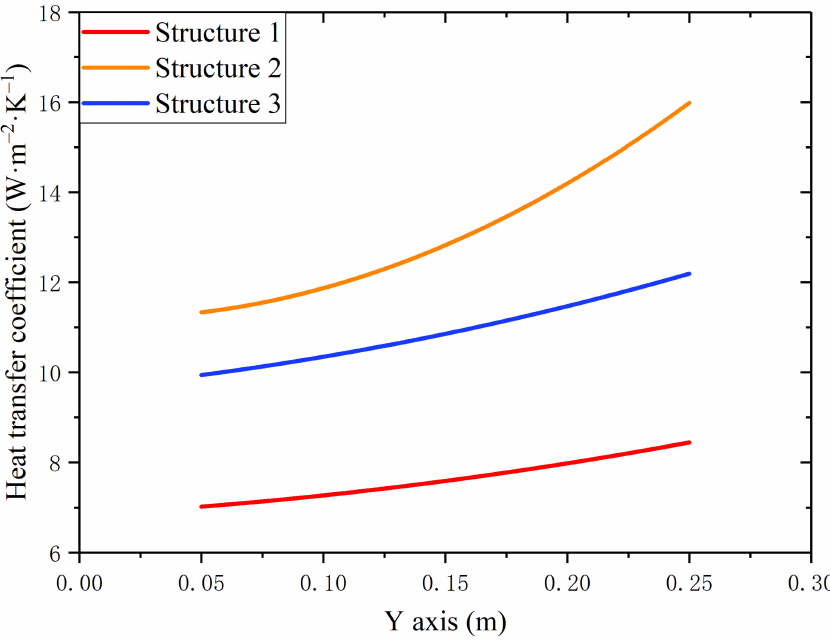
Figure 8. The heat transfer coefficients of inner tubes with different structures in the bayonet heat